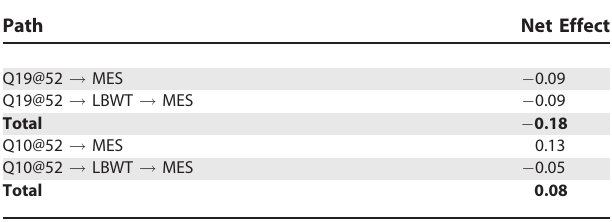
Table 3. Path Analysis of QTL Effects Path Net Effect